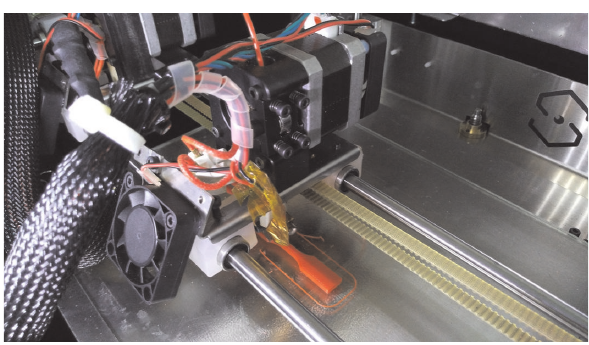
Figure 2: 3D printing process of a specimen.